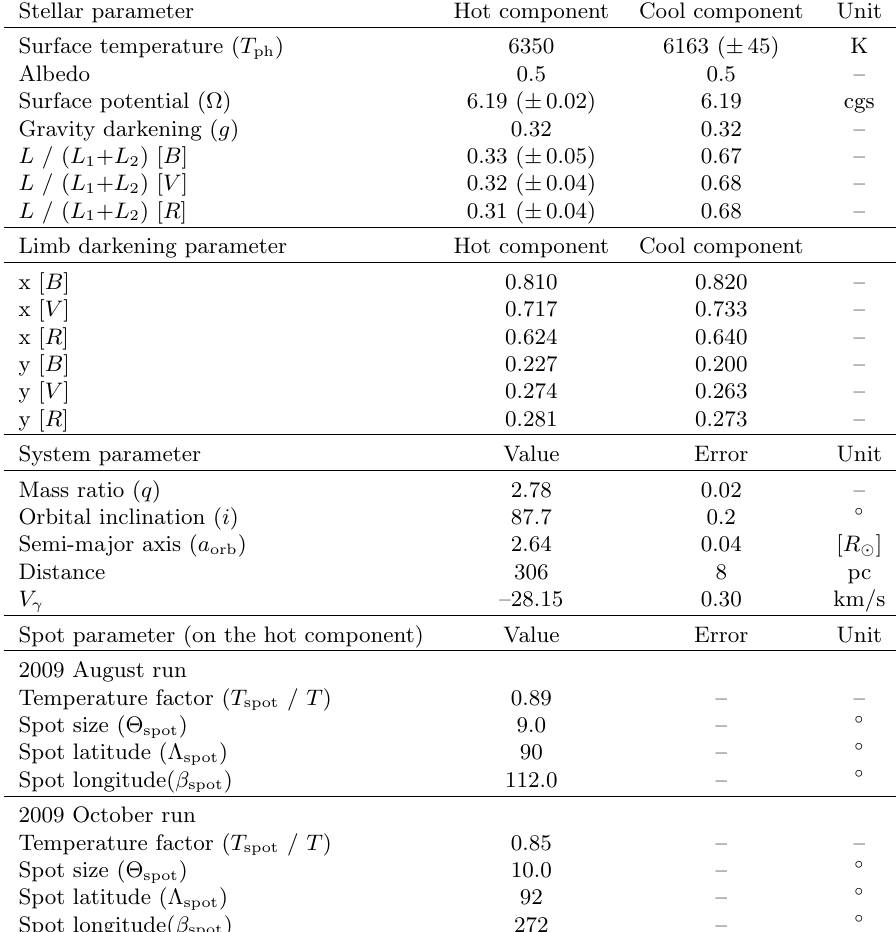
Table 6. Results of the simultaneous analysis of the light and radial velocity curves of BB Peg.